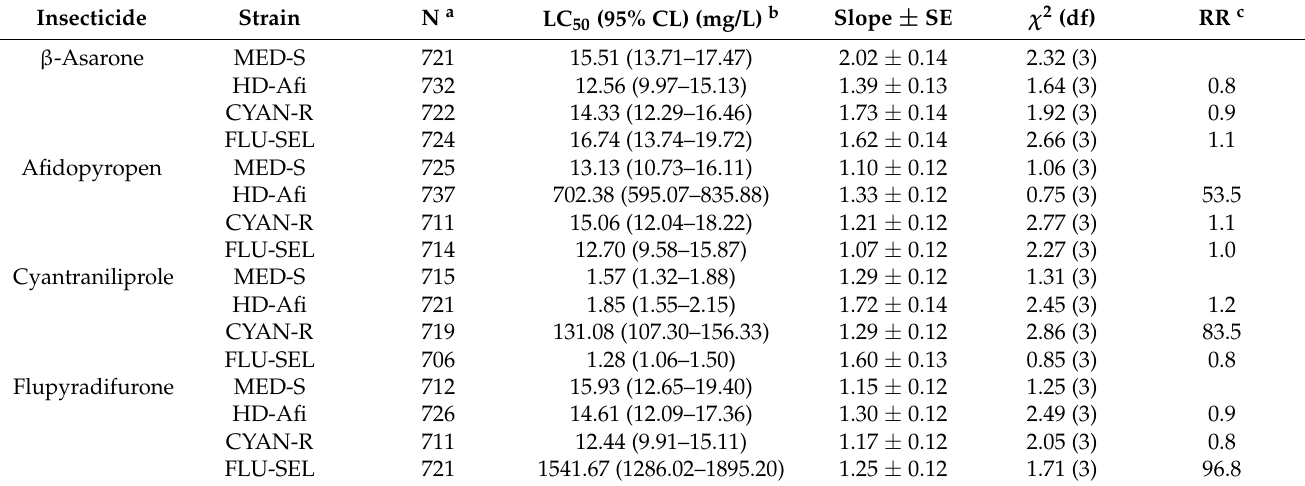
Table 2. Cross-resistance patterns to β -asarone and three popular insecticides against B. tabaci .